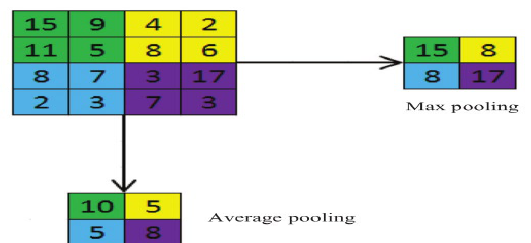
Figure 3. Illustration of Max Vs. Average Polling